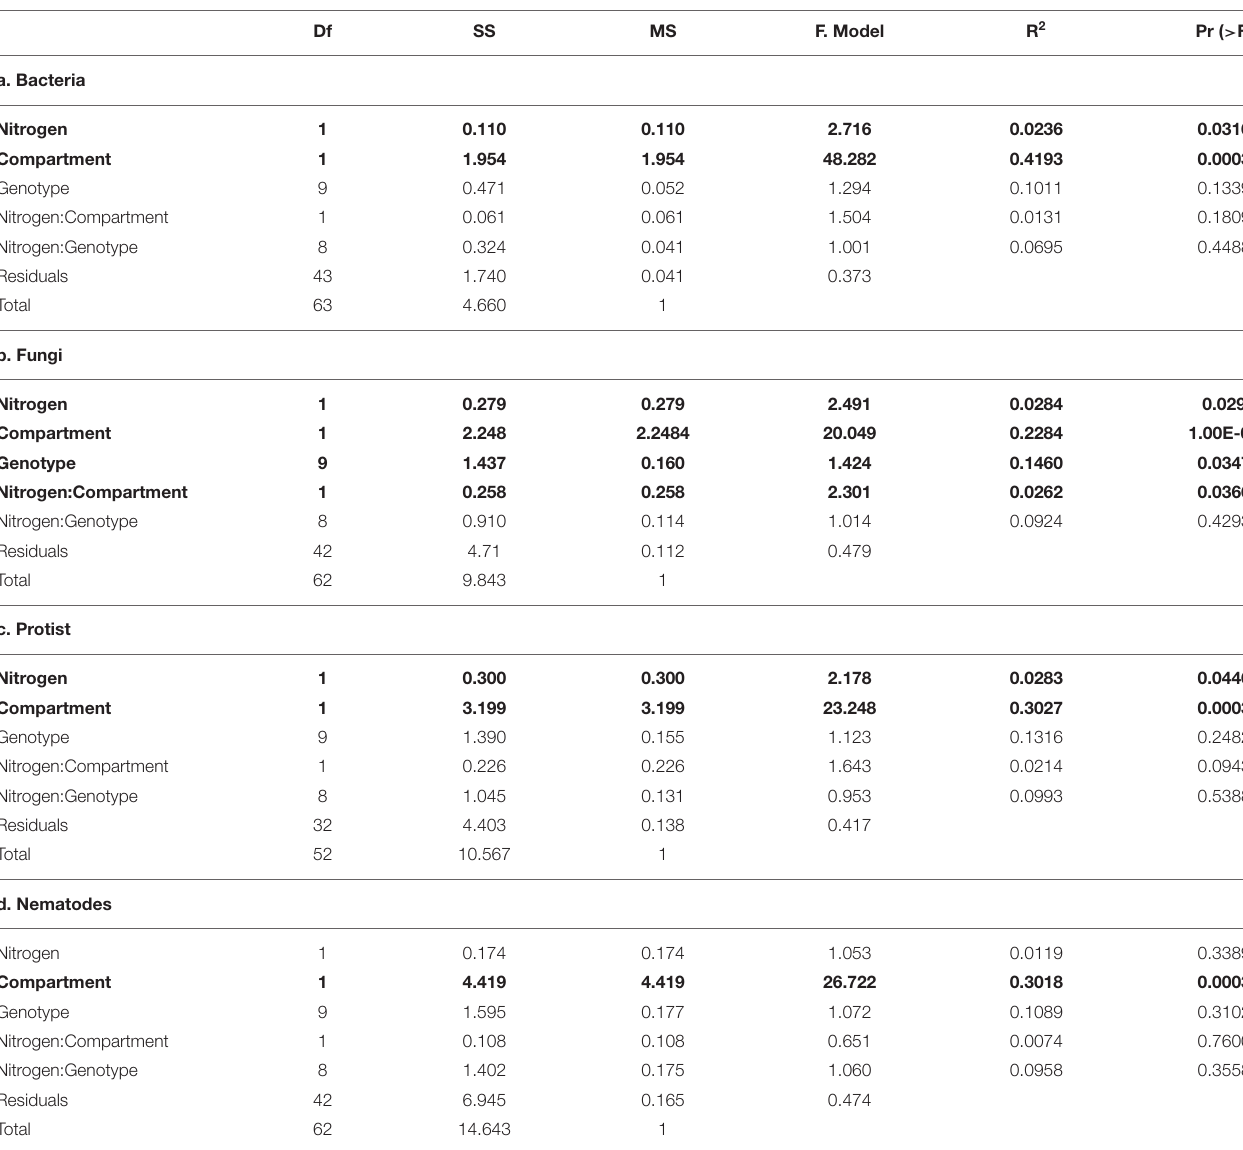
TABLE 2 | Permutational multivariate analysis of variance (PERMANOVA) of the effect of nitrogen treatment, oilseed rape genotype and compartment (soil vs. rhizosphere), and their interactions, on microbial community composition. Df SS MS F. Model R 2 Pr ( >